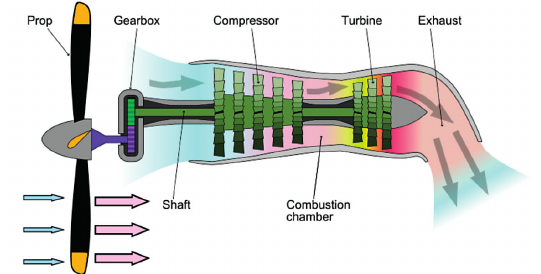
Fig. 5. Rocket engine using liquid fuel (blue indicates fuel, red − oxidizer, pink − combustion)